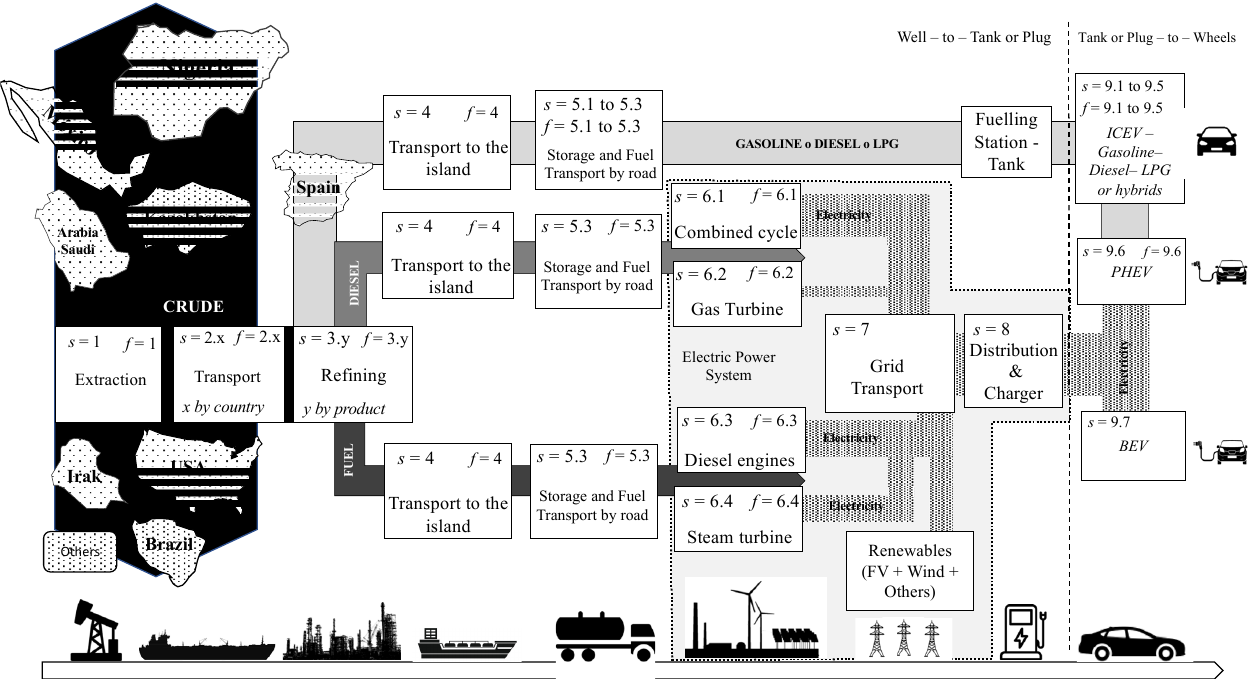
Figure 3. Pathways from the well-to-wheels in the Canary Islands.